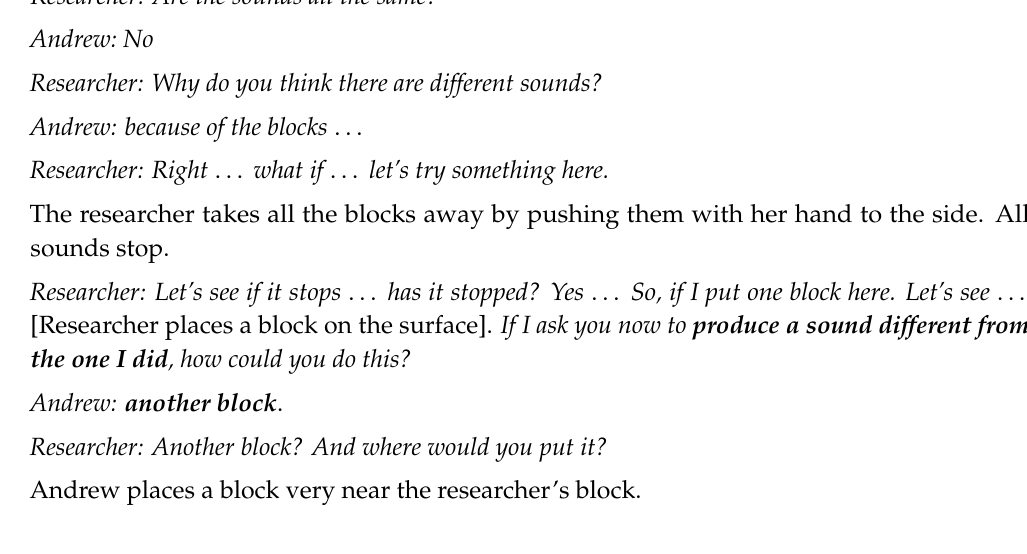
Figure 5. Block placed by Andrew (marked with circle) when asked to produce a different sound from the one produced by researcher with block marked with rectangle. 4.3. Sifteo Cubes with Loop Loop Loop Loop, another musical application used in the studies, also has cubes as controllers of sounds, the difference being that they are not mere control devices. Loop Loop is an application